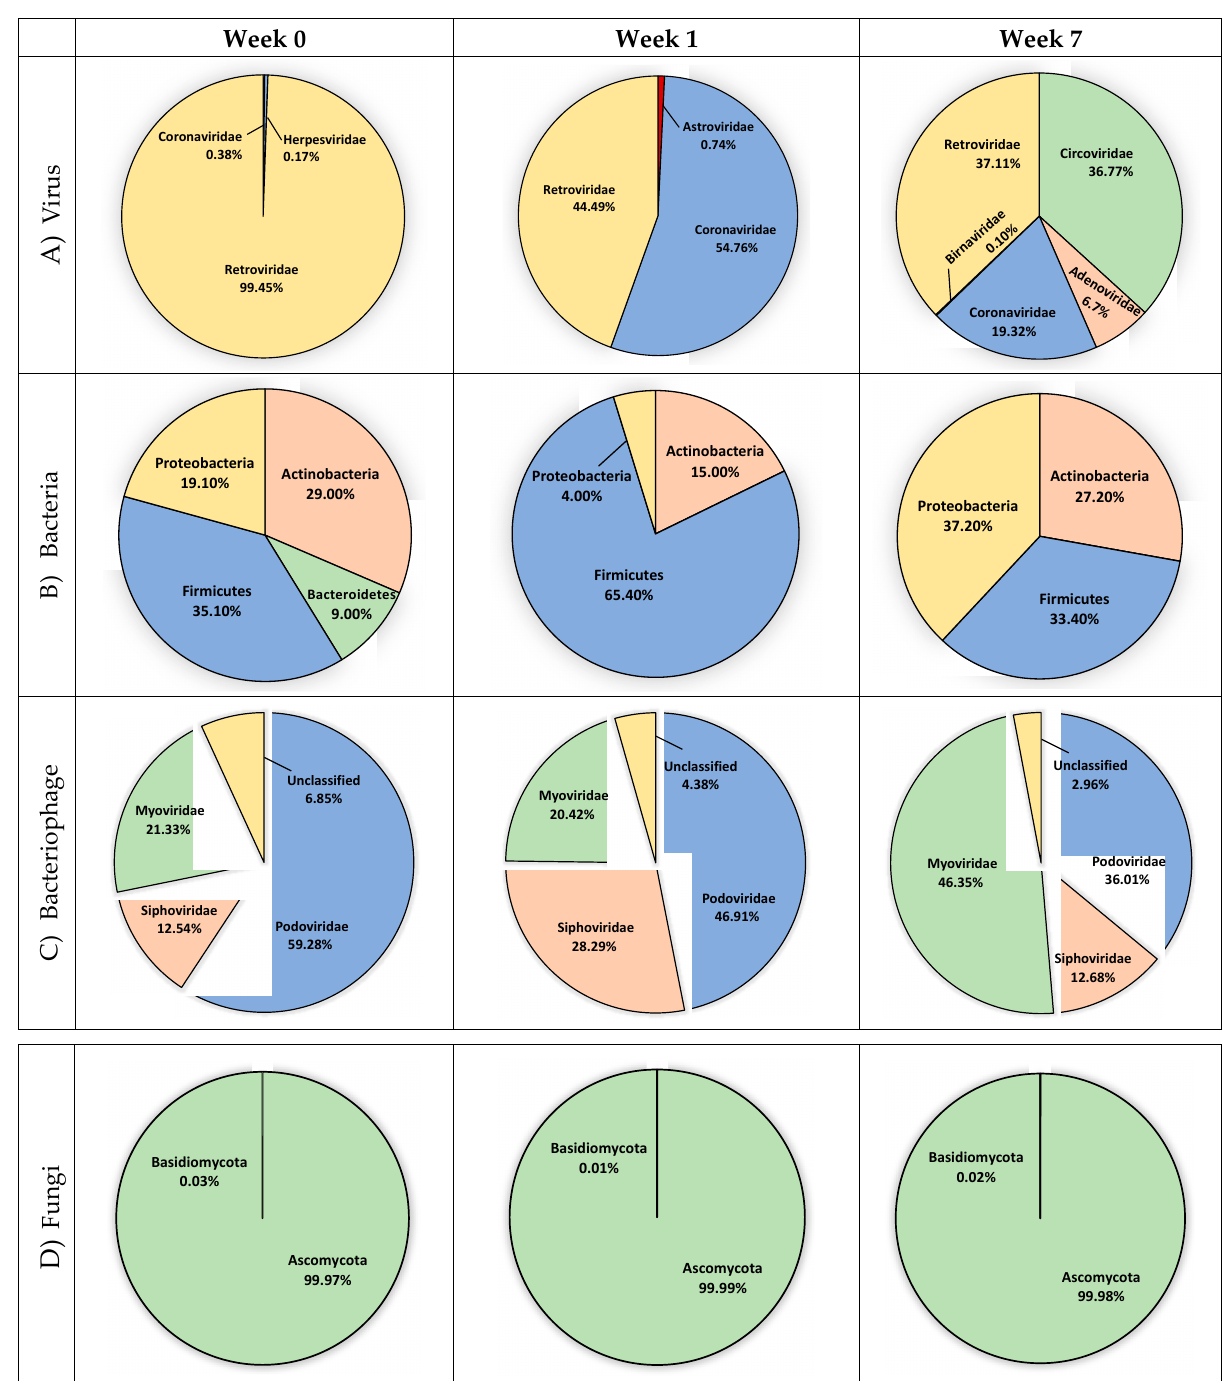
Figure 4. Abundance of ( A ) virus, ( B ) bacteria, ( C ) bacteriophage and ( D ) fungi at Week 0, Week 1 and Week 7. Taxa represented at family ( A , C ) and phylum ( B , D ) level.